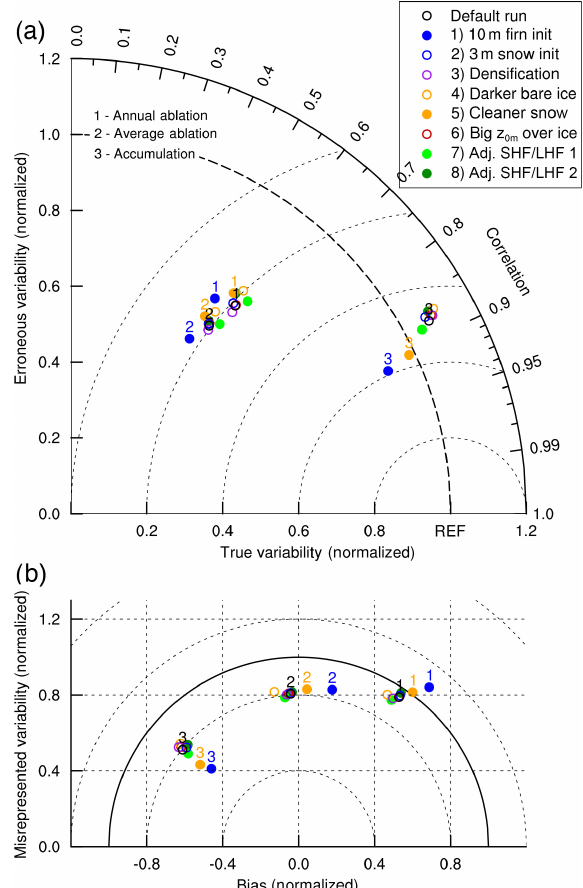
Figure 10. Sensitivity of the comparison of modelled SMB to ob- servations as a function of snow initialisation, tuning, and specific parameterisations, all derived using the 20km resolution domain expressed by (a) a Taylor diagram and (b) RMSD contribution dia- gram like Fig. 7b and